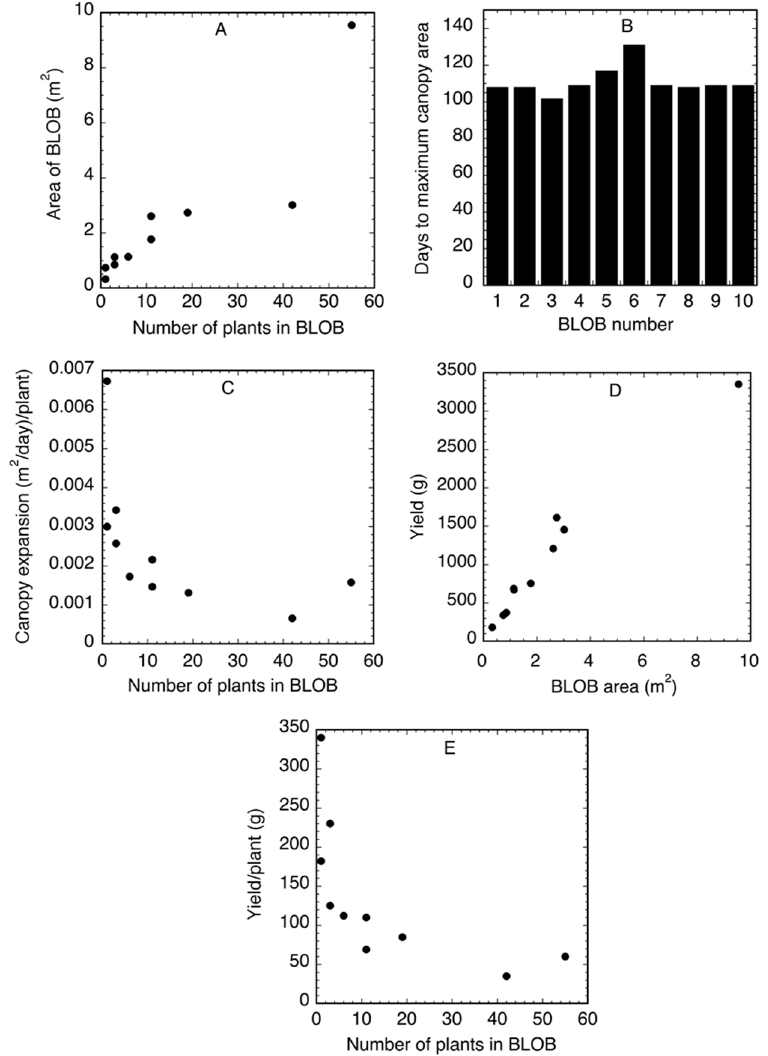
Figure 7. Agronomic data extracted from 10 binary large object-based areas of measurement (BLOB-based AOMs). ( A ) Area of a BLOB as a function of the number of plants per BLOB. ( B ) Number of days required for the canopy to reach its maximum area. ( C ) The seasonal rate of canopy expansion. ( D ) The yield (g) as a function of the area of a BLOB. ( E ) The per plant yield as a function of the number of plants in each BLOB.